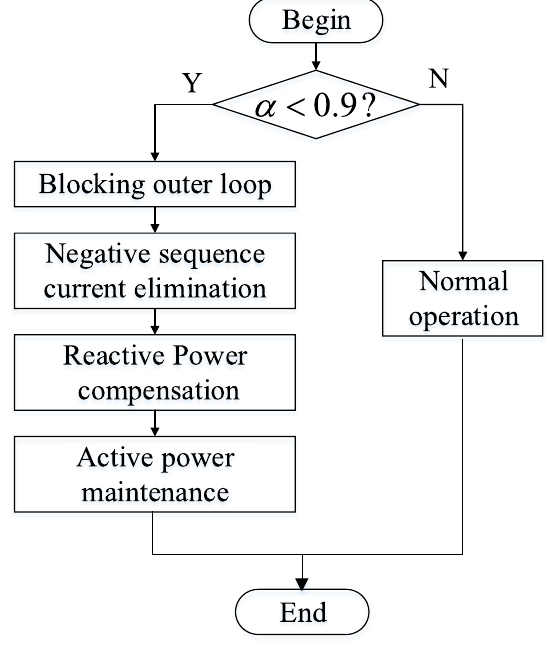
Fig. 5 LVRT strategy of